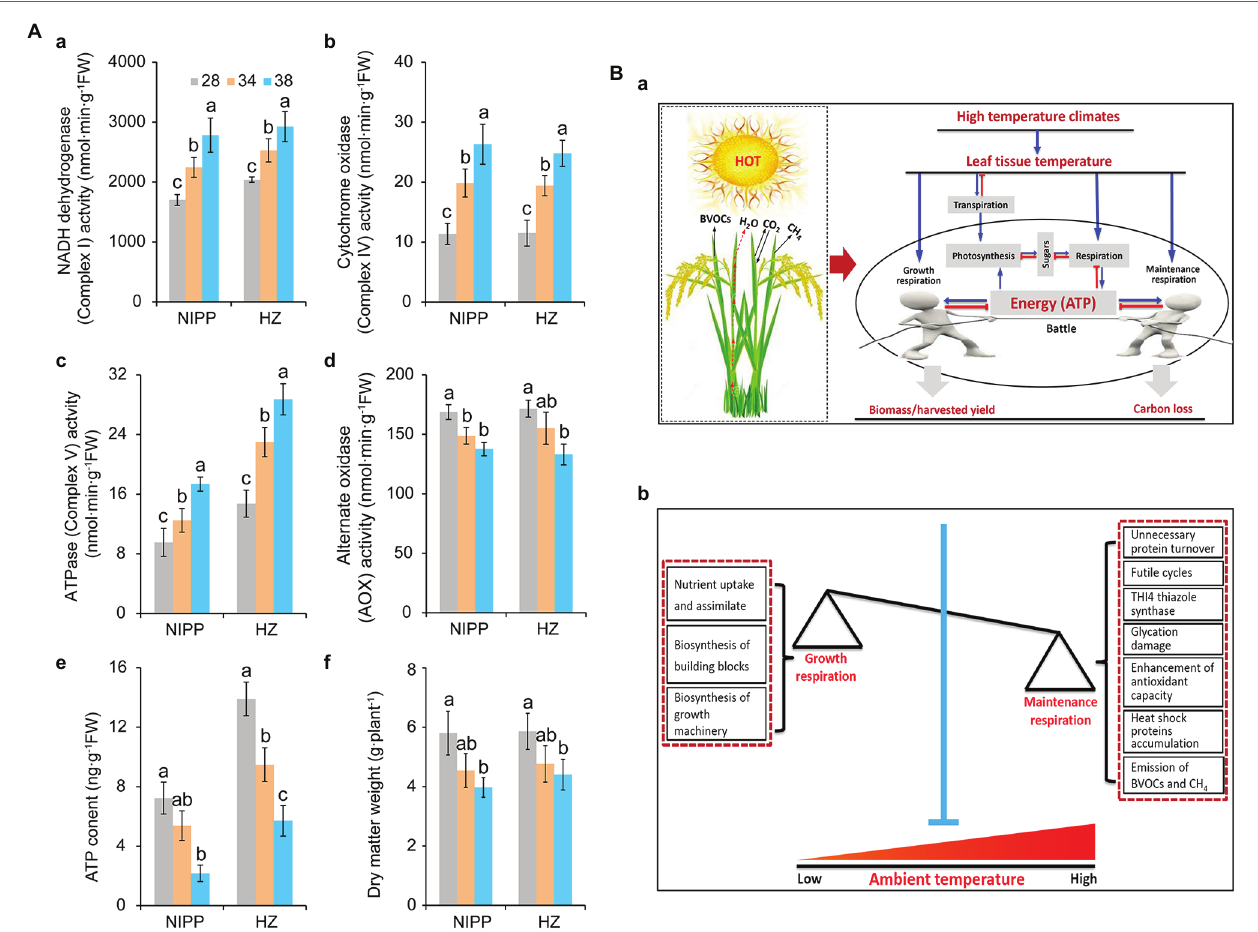
FIGURE 2 | Effect of heat stress on dry weight and energy metabolism of rice plants. (Aa) NADH dehydrogenase; (Ab) Cytochrome c oxidase; (Ac) ATPase; (Ad) Alternative oxidase (AOX); (Ae) ATP content; and (Af) Dry weight. (Ba) The effect of leaf temperature on photosynthesis, respiration, and biomass of rice plants under high-temperature conditions. Leaf temperature and transpiration rate increase with increasing ambient temperature. Due to transpiration, plant leaf temperatures tend to be far below the ambient temperature, particularly under high-temperature conditions. In this case, moderate high temperature caused little damage to photosynthesis but increased respiration, requiring the consumption of more carbohydrates to produce ATP through respiration for the maintenance of biological activity. Plant biomass or harvest yield is determined by growth respiration and maintenance respiration under high-temperature conditions. (Bb) A model of the relationship between growth respiration and maintenance respiration in plants under global warming. The maintenance respiration processes, such as unnecessary protein turnover, futile cycling, THI4 thiazole synthase, glycation, antioxidant capacity, heat shock proteins, and even the emission of BVOCs, are activated under high temperatures. By contrast, the growth respiration processes, such as nutrient uptake and assimilation, biosynthesis of building blocks, and biosynthesis of growth machinery, are inhibited. These effects of high temperature are seen in crops with low energy utilization efficiency. Therefore, crops with high energy utilization efficiency can be engineered by inhibiting maintenance respiration processes and increasing growth respiration activities under high